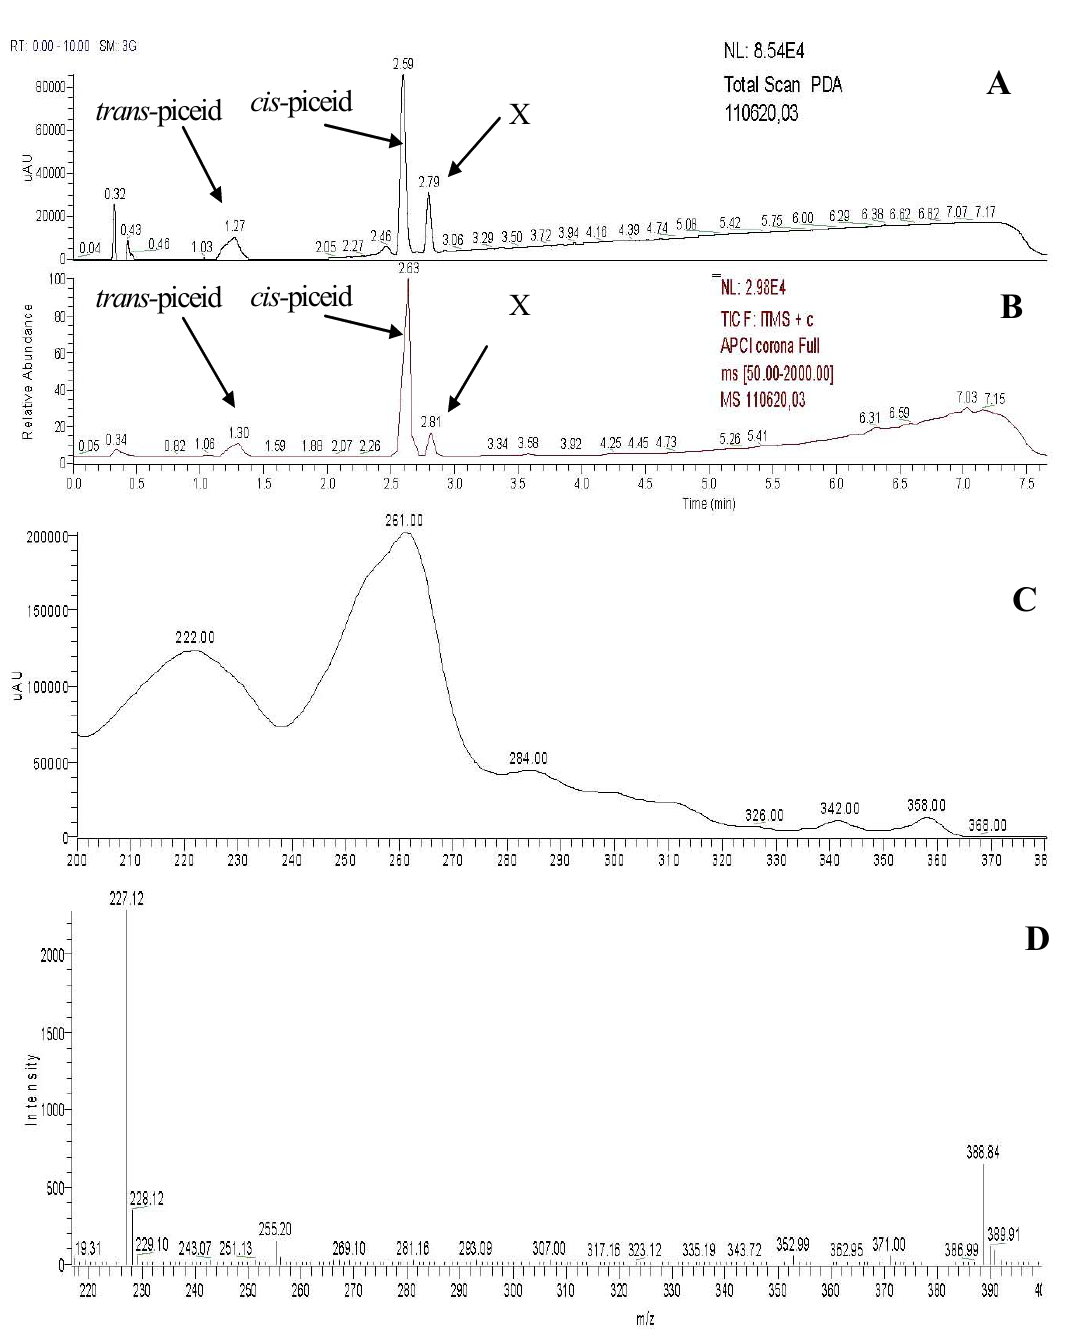
Figure 5. LC-MS analysis of the irradiated trans- piceid standard. ( A ) Total scan from the photo diode array detector. ( B ) Full spectrum from LC-MS APCI measurement in the positive mode. ( C ) UV spectrum of the peak with the retention time of 2.80 min. ( D ) Mass spectrum from LC-MS APCI measurement in the positive mode of the peak with the retention time of 2.80